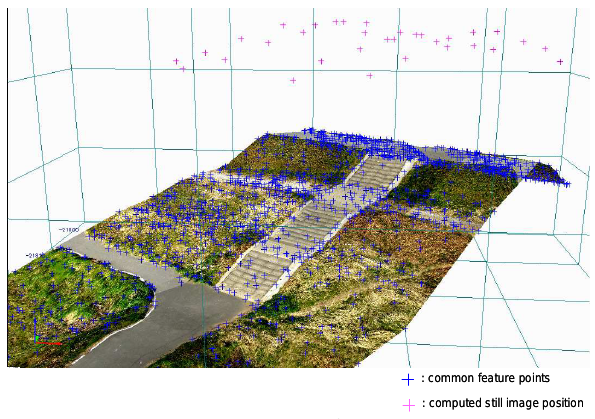
Figure 12. 3D model of Second